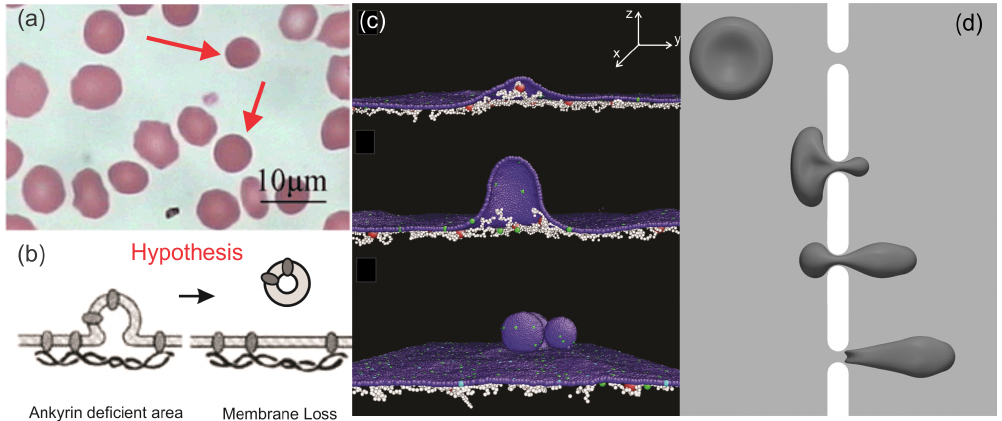
Figure 7. ( a ) Optical microscopy images of peripheral blood smears of HS patients after splenectomy. Reproduced with permission from reference [119]. ( b ) Hypothesis for RBC membrane loss in HS proposed in reference [120]. ( c ) Simulations of membrane vesiculation of defective RBC membranes in HS using the coarse-grained molecular dynamics (CGMD) method. Reproduced from reference [121] with permission. ( d ) Simulations of a RBC passing through a narrow slit using the finite element method. Reproduced from reference [122] with